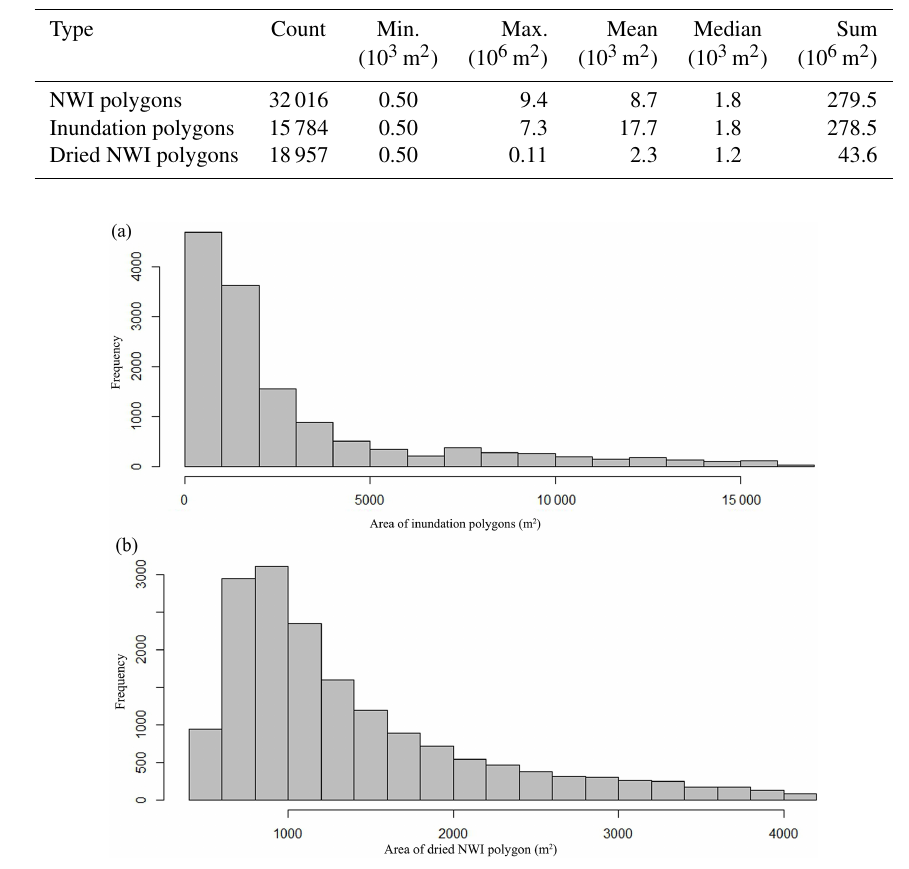
Table 2. Summary statistics of NWI wetland polygons and inundation polygons derived from lidar intensity data.